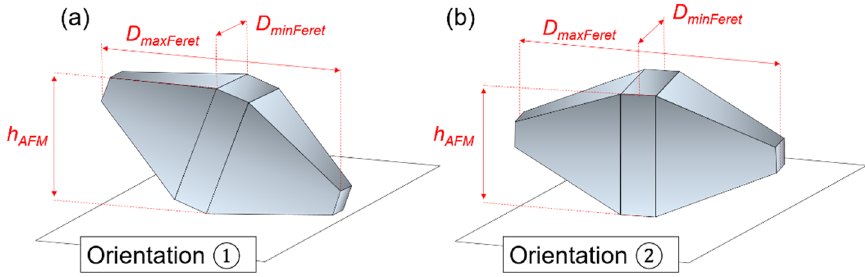
on the substrate after deposition for microscopy measurements.